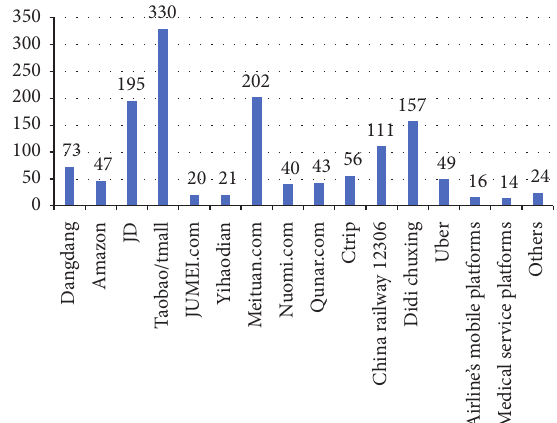
Figure 5: The main mobile sales terminals used by